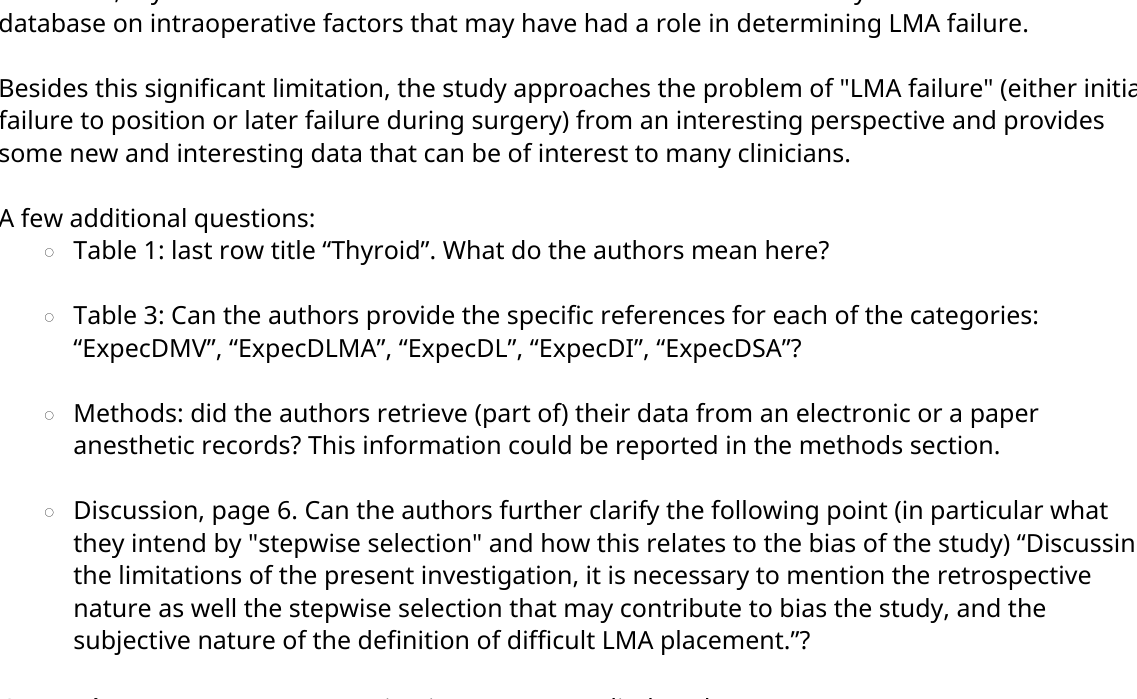
Table 1: last row title “Thyroid”. What do the authors mean here? ○